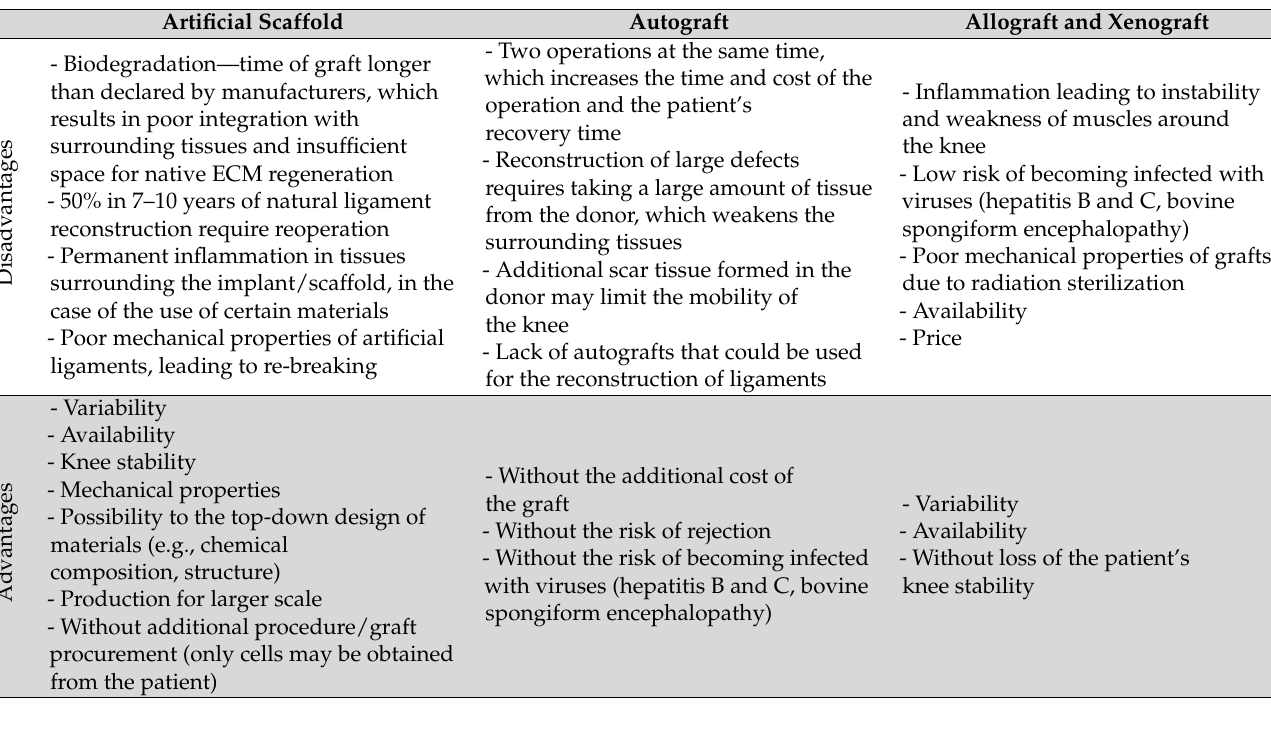
Table 1. Advantages and disadvantages of artificial and natural grafts available on the market. Artificial